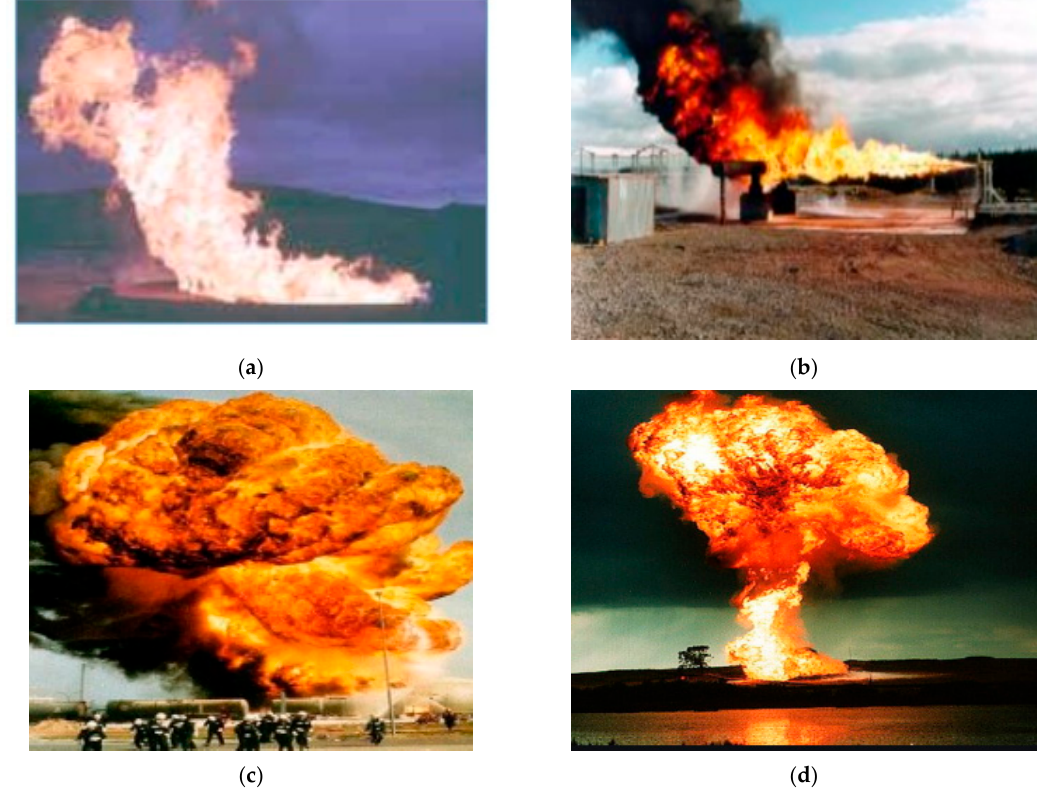
Figure 1. Example of each fire explosion case: ( a ) pool fire, ( b ) jet fire, ( c ) boiling liquid expanding vapor explosion (BLEVE), and ( d ) vapor cloud explosion (VCE).